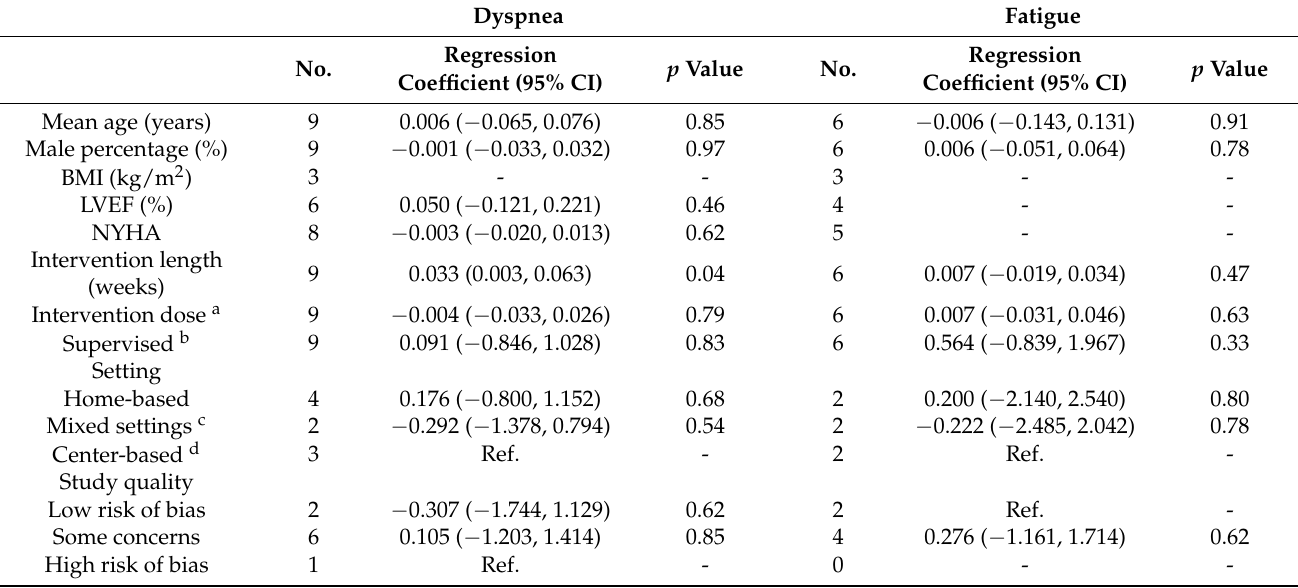
Table 2. Univariate meta-regression